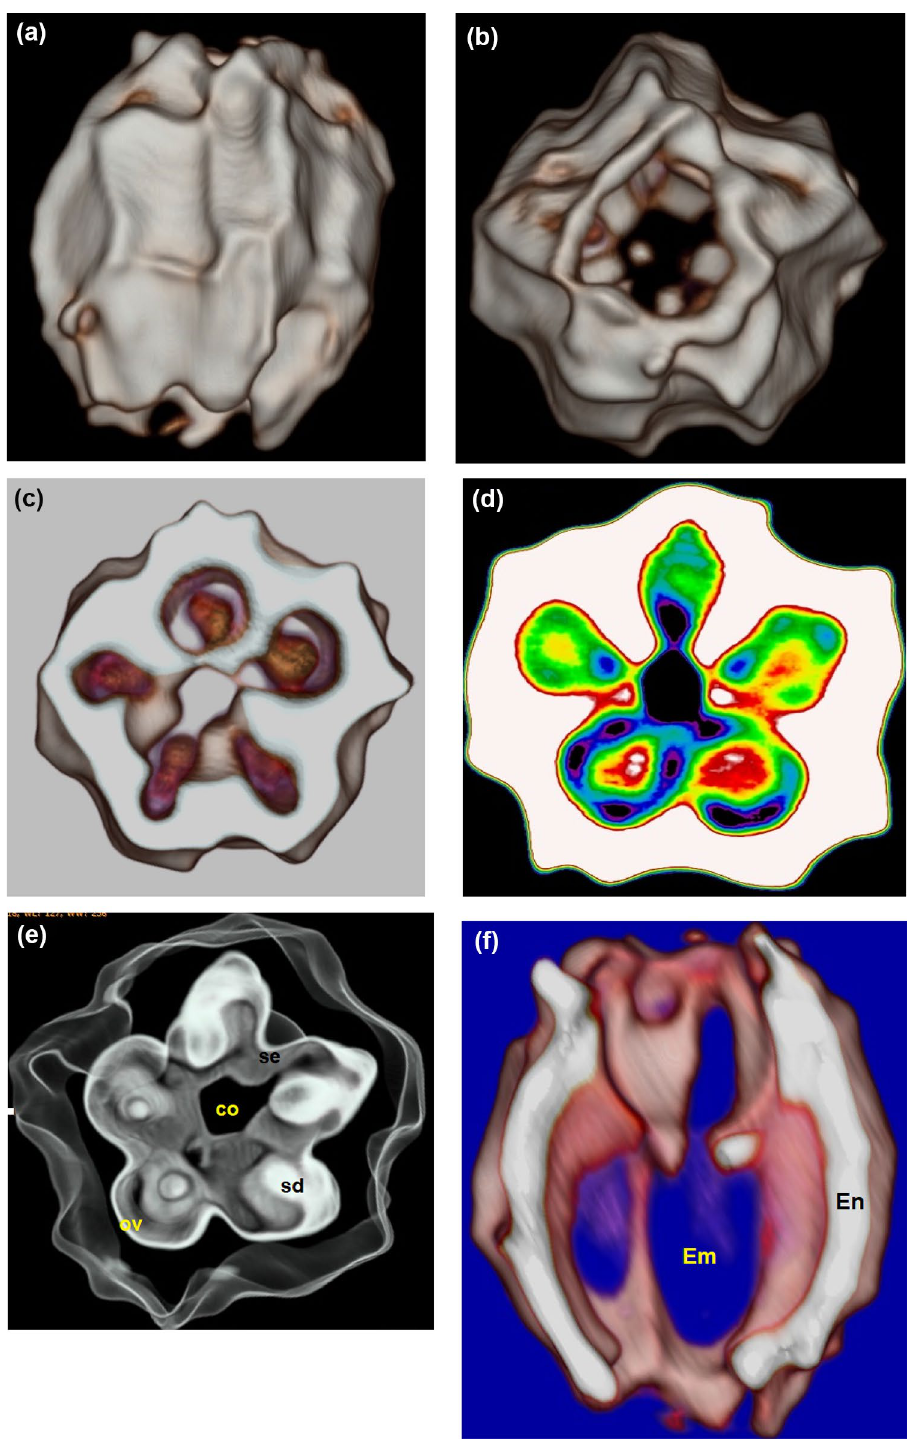
Figure 3. CT tomography showing the morphological features of the archaeobotanical specimen; ( a ) surface side view; ( b ) surface top view; ( c , d ) transverse sections showing the seeds within ovules; ( e ) scanned whole view of the cone ( Se septa, Co columella, Sd seed, Ov ovules); ( f ) longitudinal or side view ( En endosperm, Em